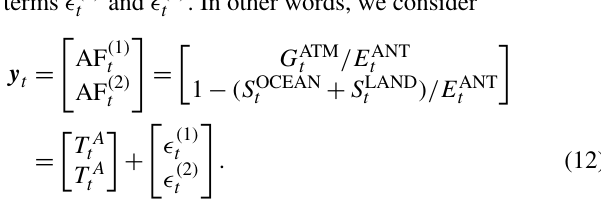
Parameter estimates